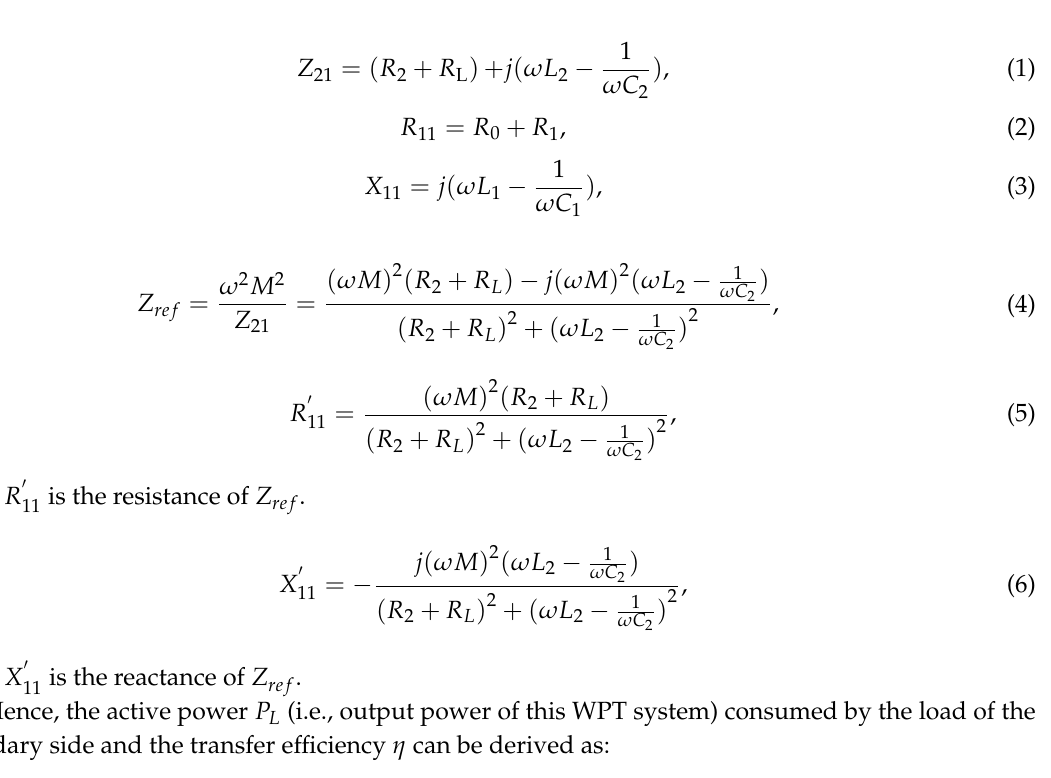
Figure 4. Simplified circuit model of the WPT